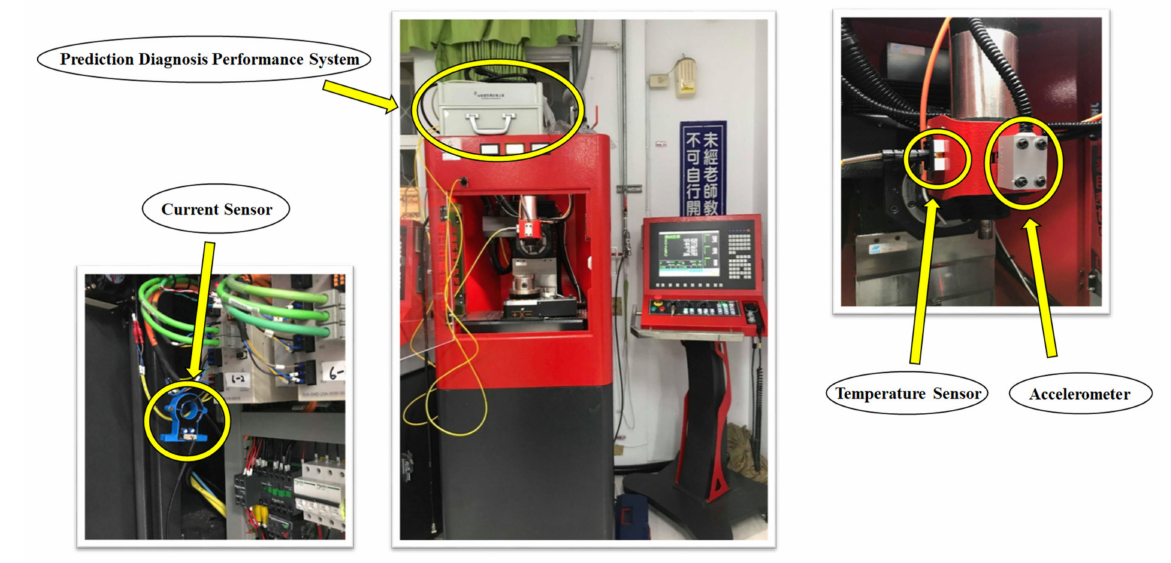
Figure 5. Machine tool smart manufacturing.